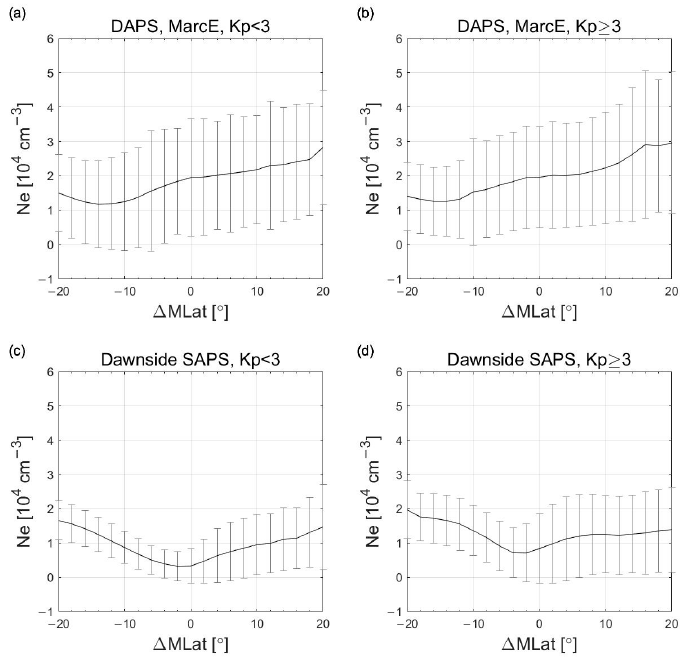
Figure 5. Superposed epoch analyses of the plasma density (Ne) for DAPS ( a , b ) at March equinox and dawnside SAPS events ( c , d ) without seasonal separation under different geomagnetic activity levels. The 0 key MLat denotes the latitude where the cross-track velocity (DAPS or SAPS) peaks. The bars show the standard deviations of 2° averages. Table 4. The mean plasma density (Ne) at the latitudes where the DAPS and dawnside SAPS peak under two different Kp levels. The abbreviation MarcE denotes the March equinox, JuneS denotes the June solstice, SeptE denotes the September equinox, and DeceS denotes the December solstice. Plasma Density, Ne (10 4 /cm 3